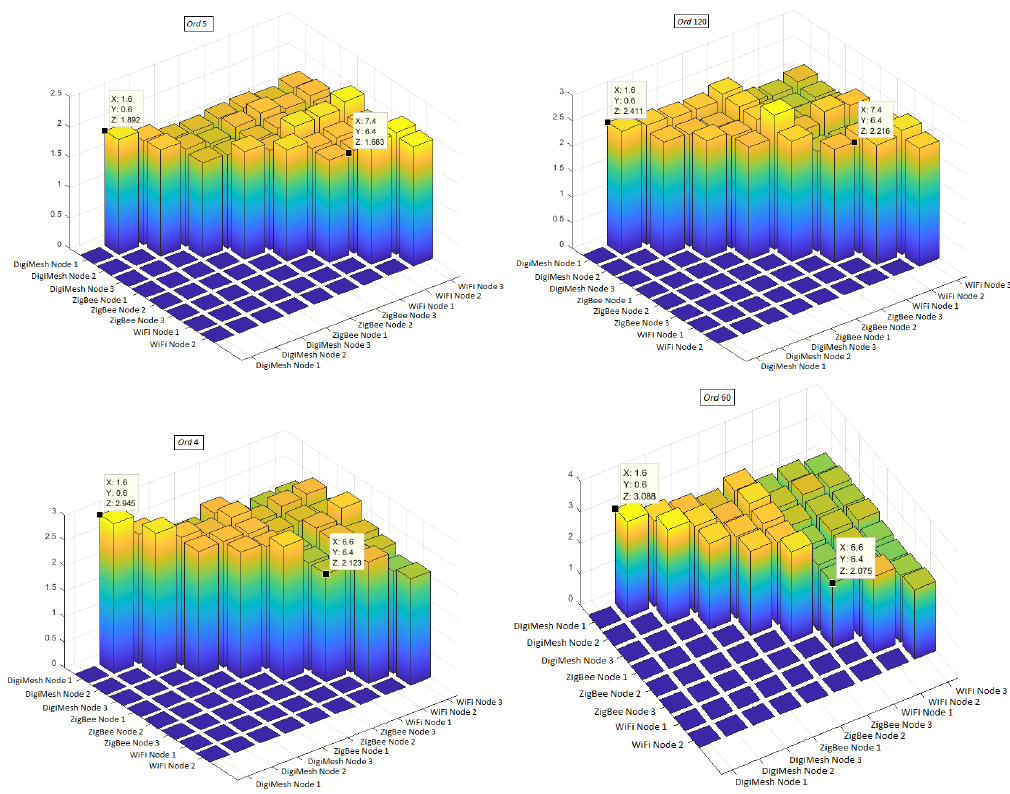
Figure 18. MI comparison with change of Ord between all different sensor nodes of the three WSNs for luminosity and air relative humidity. from top to